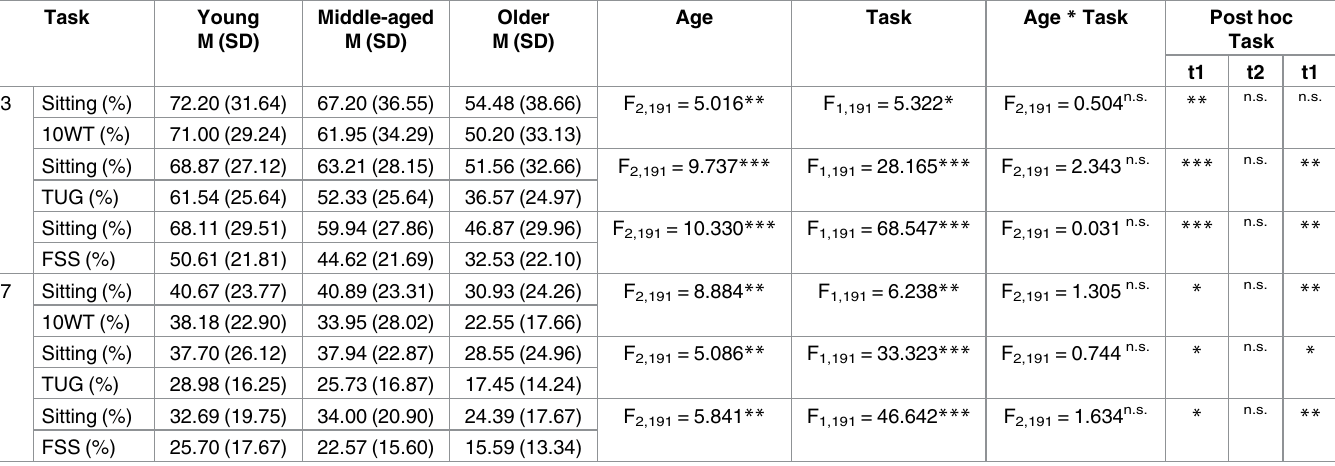
Table 6. ANCOVAsand post hoc results of the cognitive performance